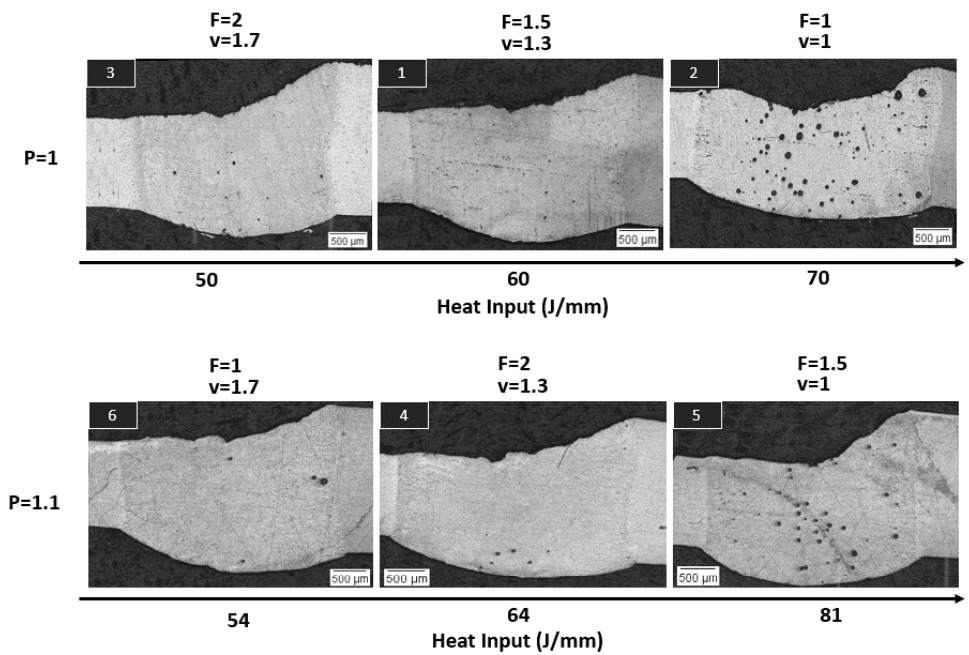
Figure 5. Cross-sections of the welded joints at varying welding conditions. P: laser power (normal- ized value); v: welding speed (normalized value); F: focus position (mm).